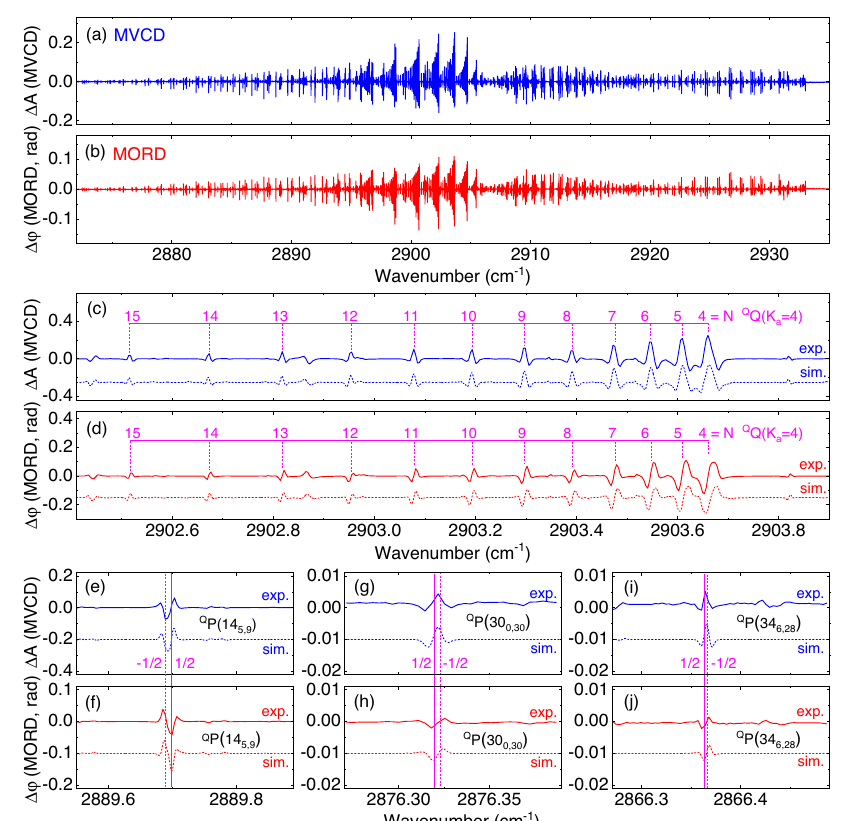
Fig. 4 | Magnetic vibrational optical activity signals of nitrogen dioxide. a , b Retrieved MVCD and MORD spectra of NO 2 covered from 2870 to 2940cm − 1 , respectively. c and d MVCD and MORD spectral lines of the Q Q(K a =4) subbranch, thedashedlinesbelowarethesimulationresults. e , g , i ( f , h , j )MVCD(MORD)lines of the Q P(14 5,9 ), Q P(30 0,30 ), and Q P(34 6,28 ) transitions. The transition frequency of